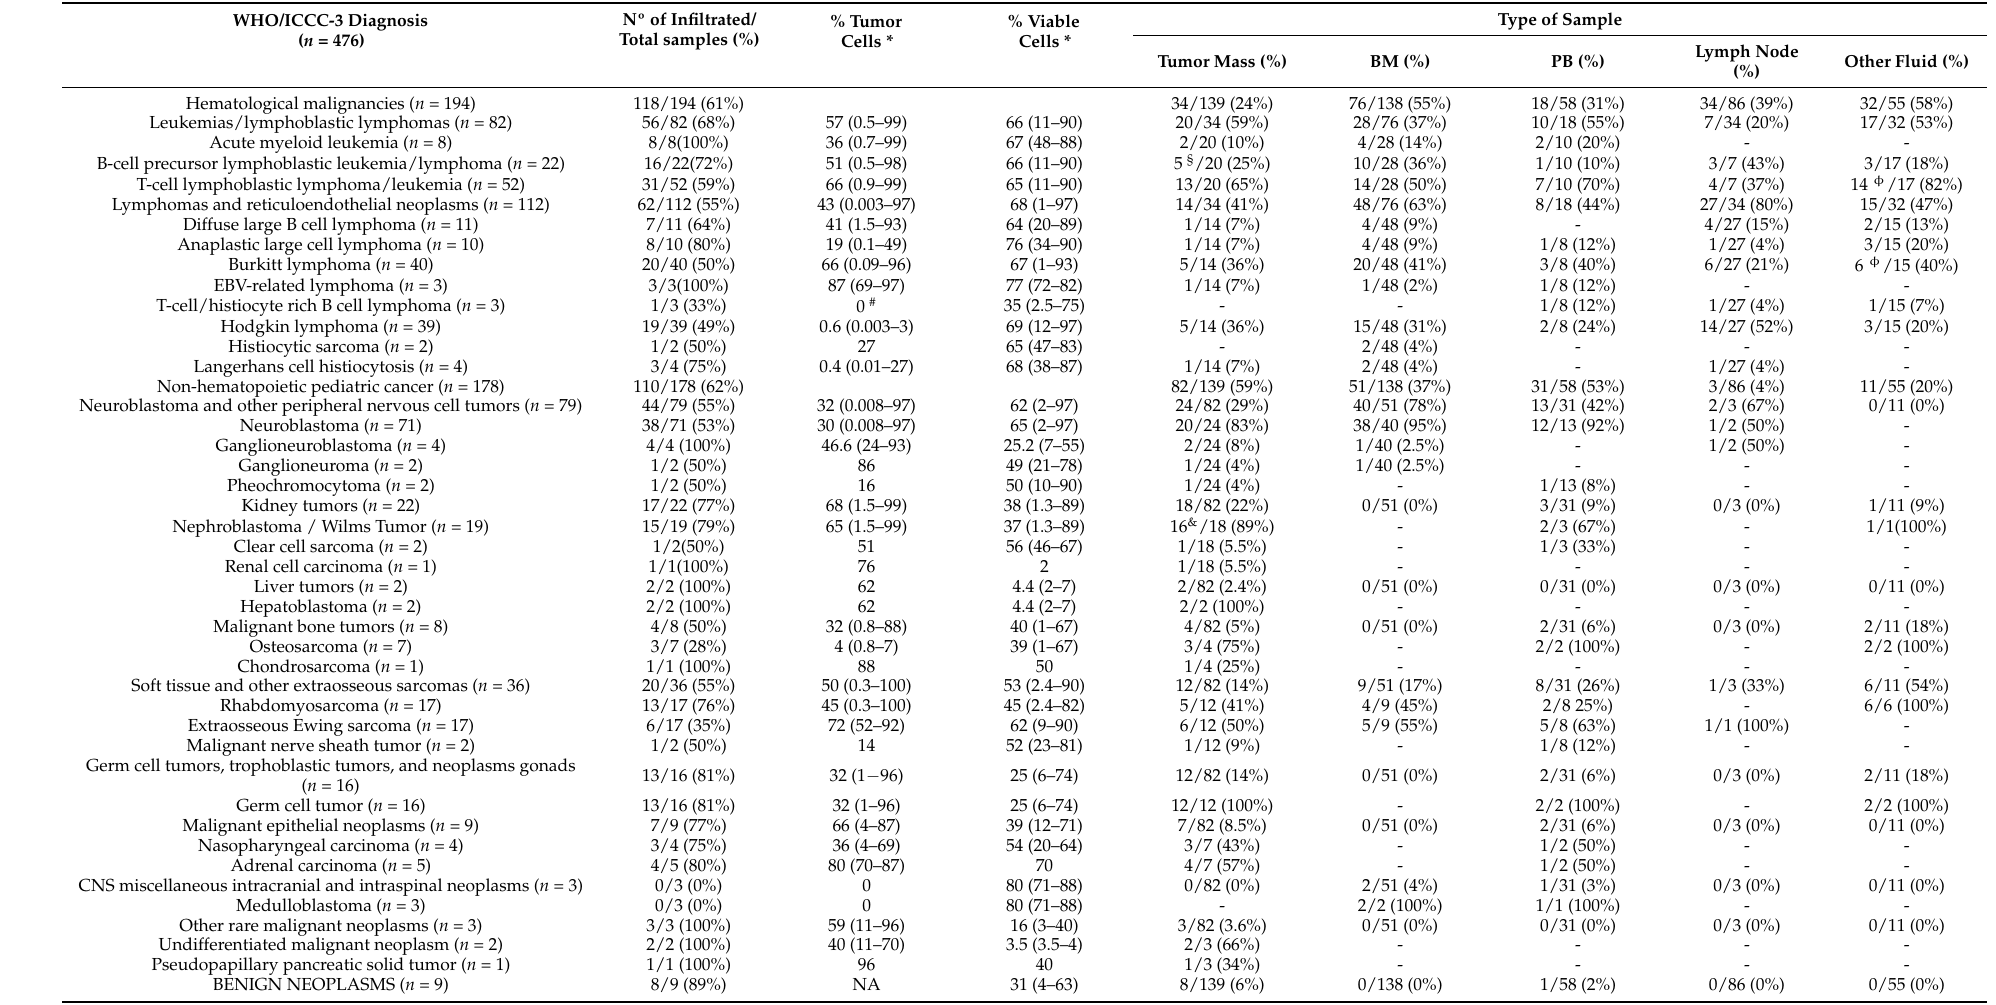
Table 1. Number of infiltrated samples with percentage of tumor cells and viable cells after excluding dead cells and cell debris, and distribution by sites analyzed, grouped according to the final (WHO/ICCC-3) diagnosis ( n = 476 samples/296